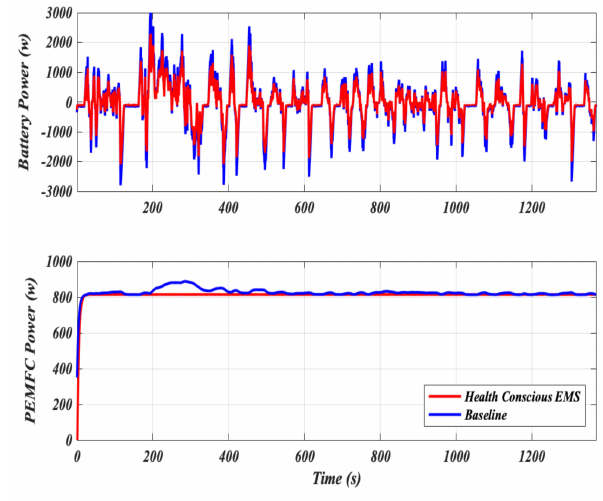
Figure 4. PEMFC and battery power for the UDDS cycle.